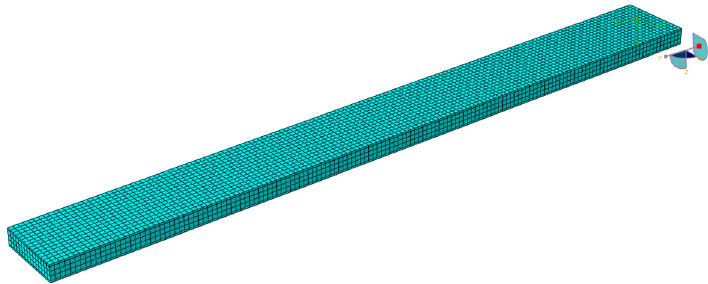
Figure 3. FEA modal of the CFRP laminate with periodic structures. Table 4. Frequency and damping ratio of CFRP laminate obtained using FEA.